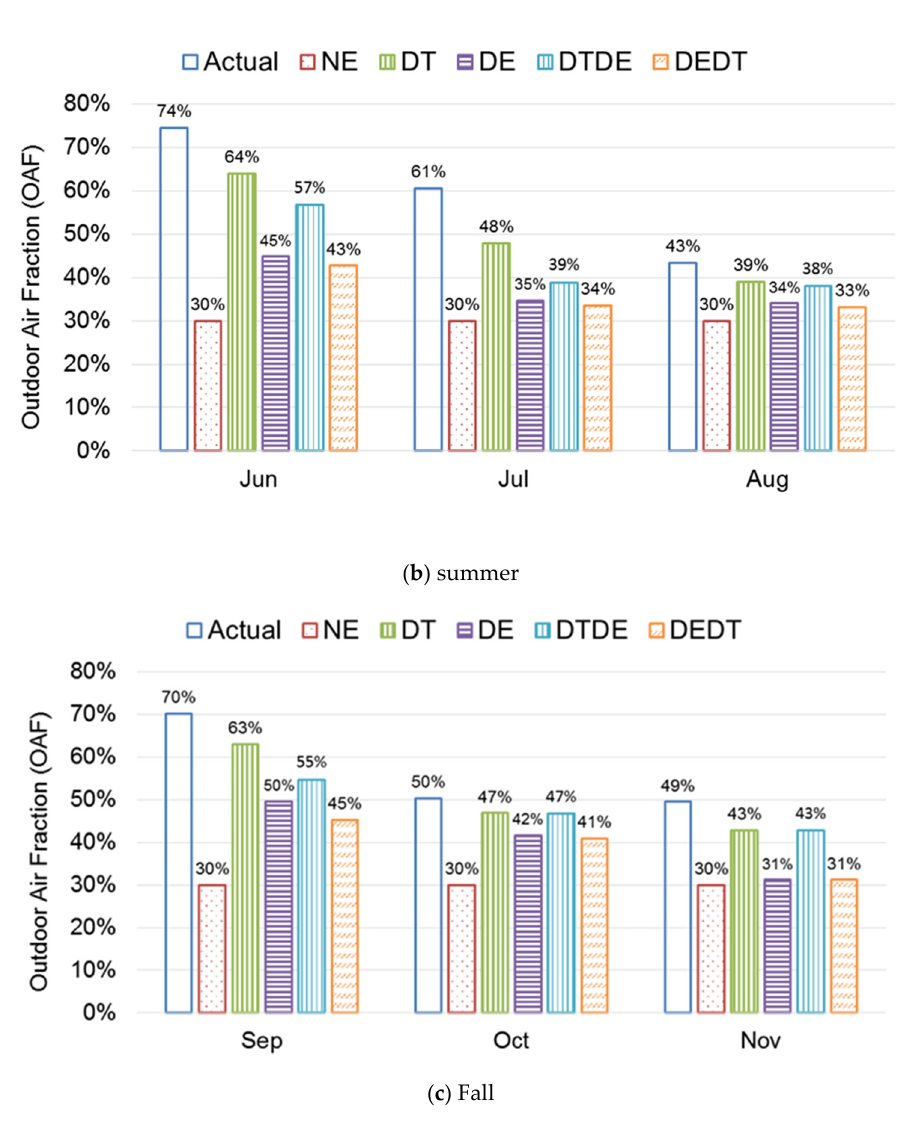
Figure 9. Average outdoor air fraction by season and control types.